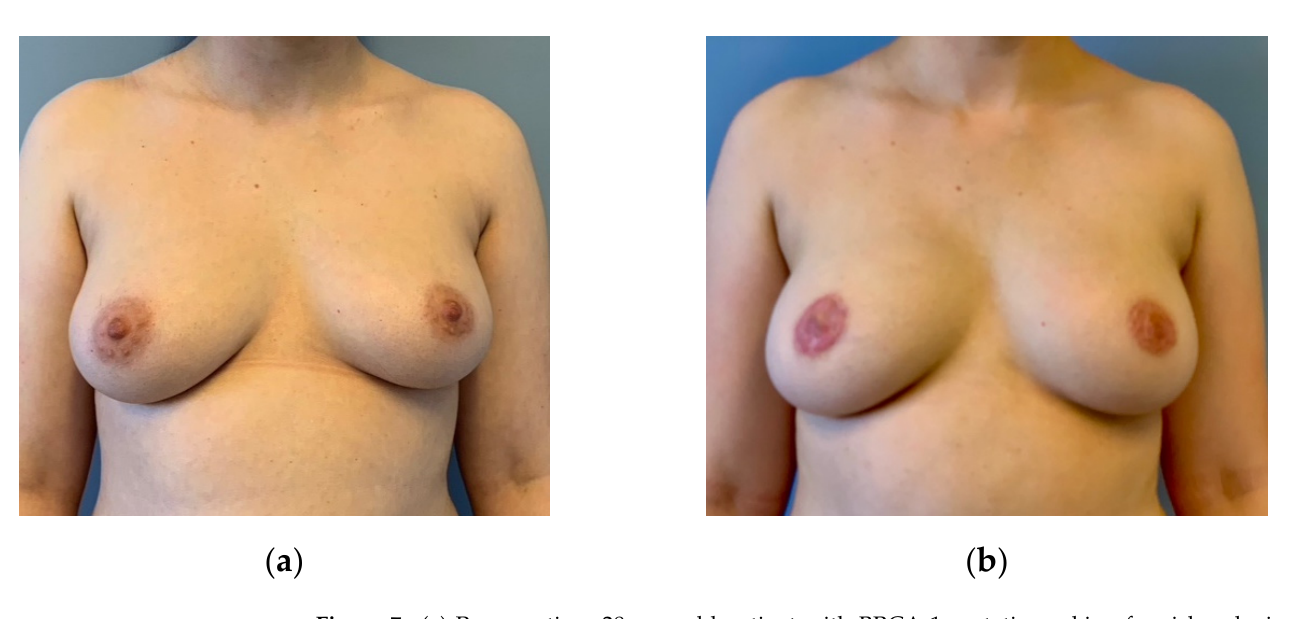
Figure 6. ( a ) Preoperative: 37-year-old patient with triple negative invasive breast cancer right, receiving neoadjuvant chemotherapy. No genetic mutation was detected. The patient desired a bilateral mastectomy. ( b ) Three months after bilateral circumareolar mastectomy and reconstruction with inner thigh flaps and free NAC grafts. No other scars evident at the breasts apart from the circumareolar. The nevus left was also excised.